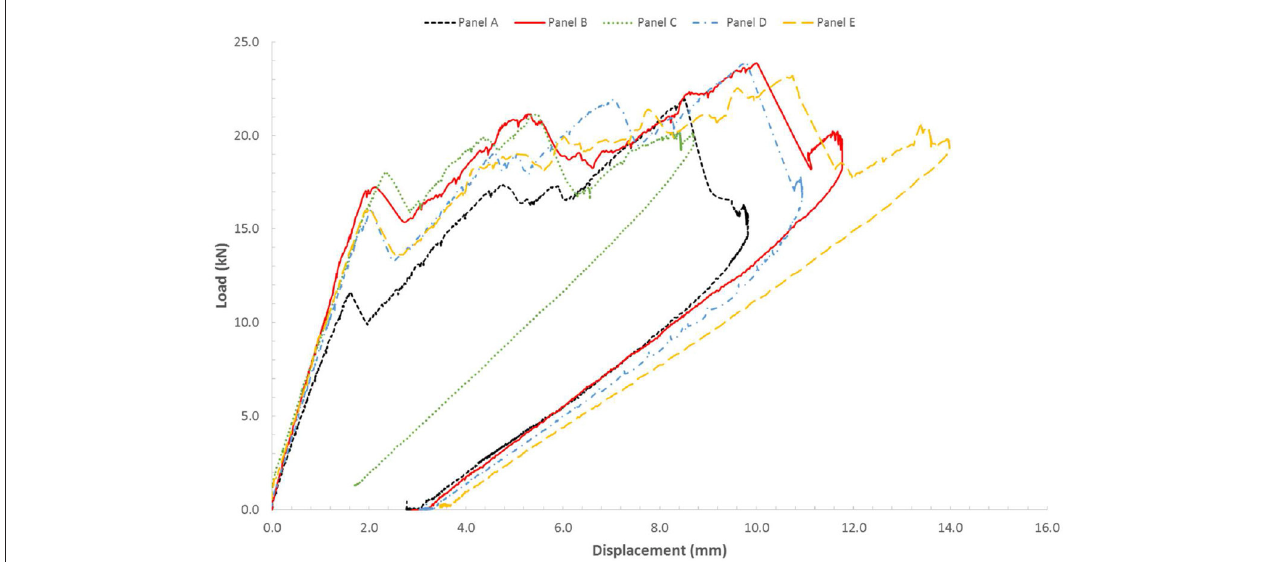
FIGURE 13 | Load-displacement curves for all panels during the initial loading stage.